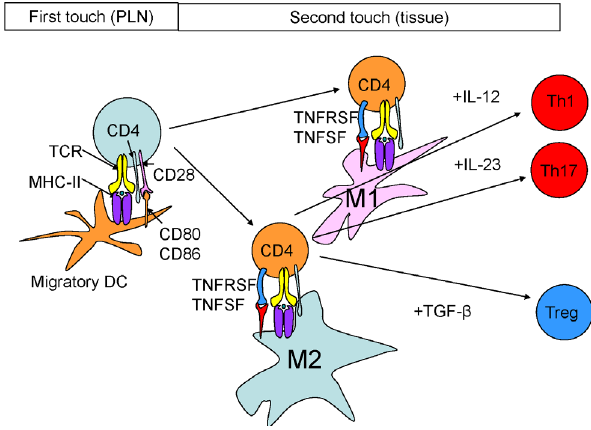
Figure 3. First and second touch. The first touch occurs in the lymph node, where the naïve T cell (light blue) is exposed to antigen (green circle) presented by MHC-II (purple) in the context of CD80 and CD86 (orange) co-stimulation, which bind CD28 (pink). The MHC-II-peptide complex is recognized by the T cell receptor (TCR, yellow) with CD4 (green). The second touch occurs in the tissue, where antigen is presented to antigen-experienced (orange) T cells by M1 (pink) and M2 (green) macrophages. Co- stimulatory molecules are likely from the TNFSF (red) on the T cell and the TNFRSF (blue) on the APC (see table for list of molecules). Characteristic M1 cytokines like IL-12 and IL-23 commit the CD4 T cell to Th1 and Th17, respectively. The M2 cytokine TGF- β commits T cells to the iTreg